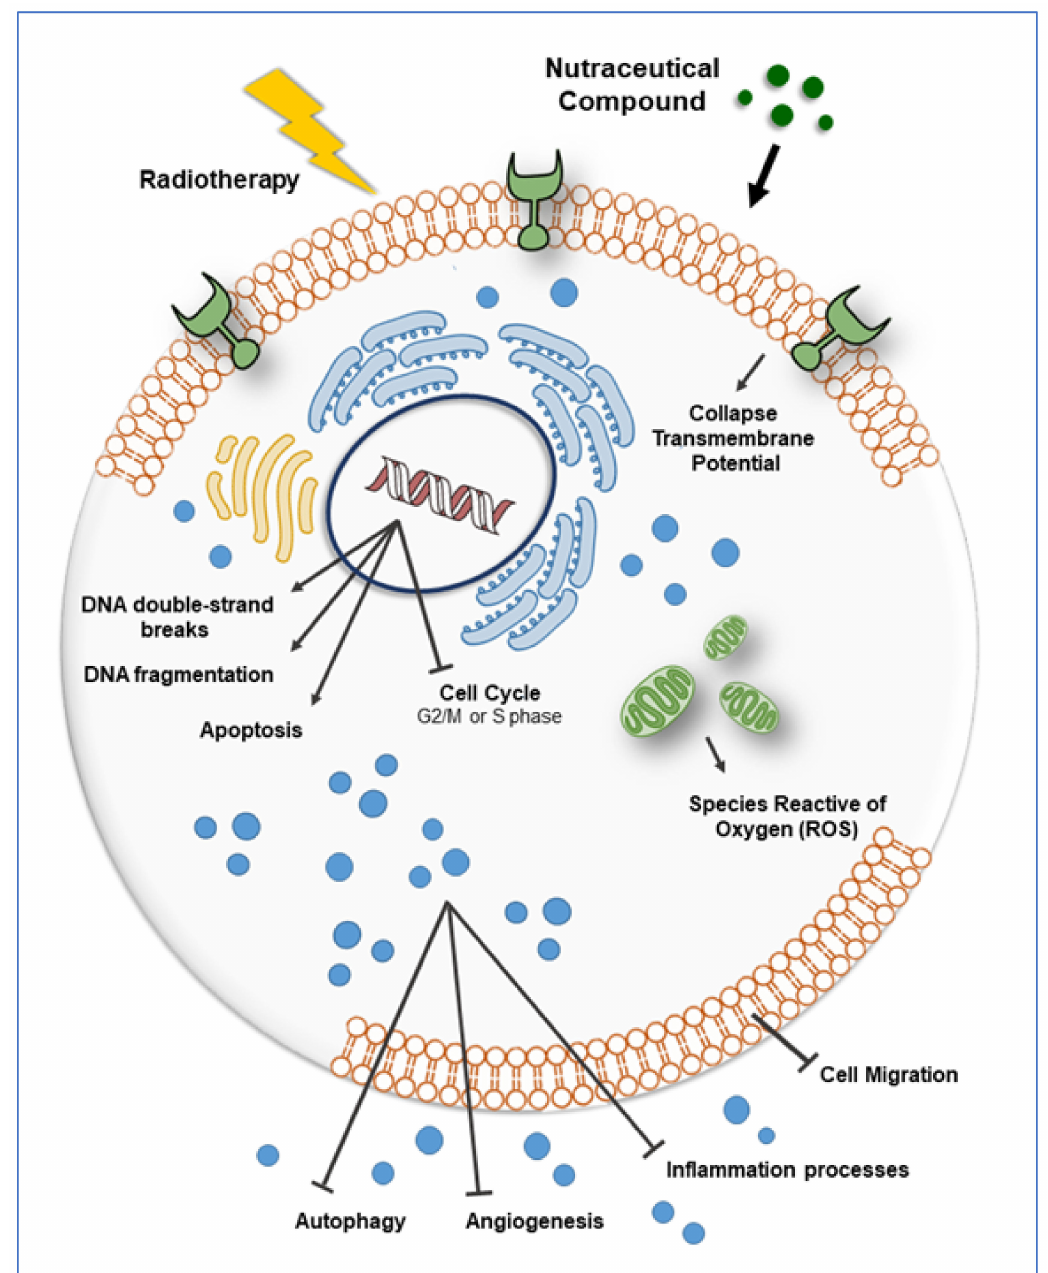
Figure 1. The figure displays how nutraceuticals compounds and radiation treatment could a ff ect cellular pathways involved in migration, inflammation, autophagy and reactive oxygen species (ROS) production